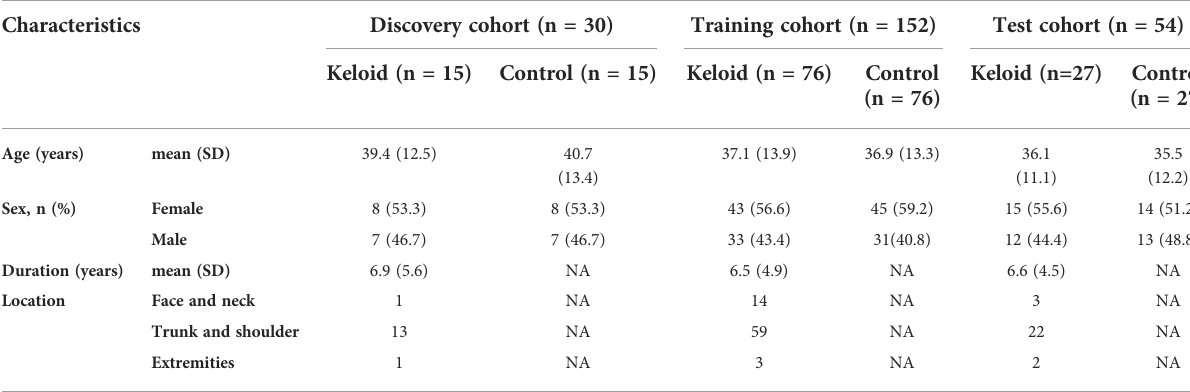
TABLE 1 Baseline clinical characteristics of subjects.